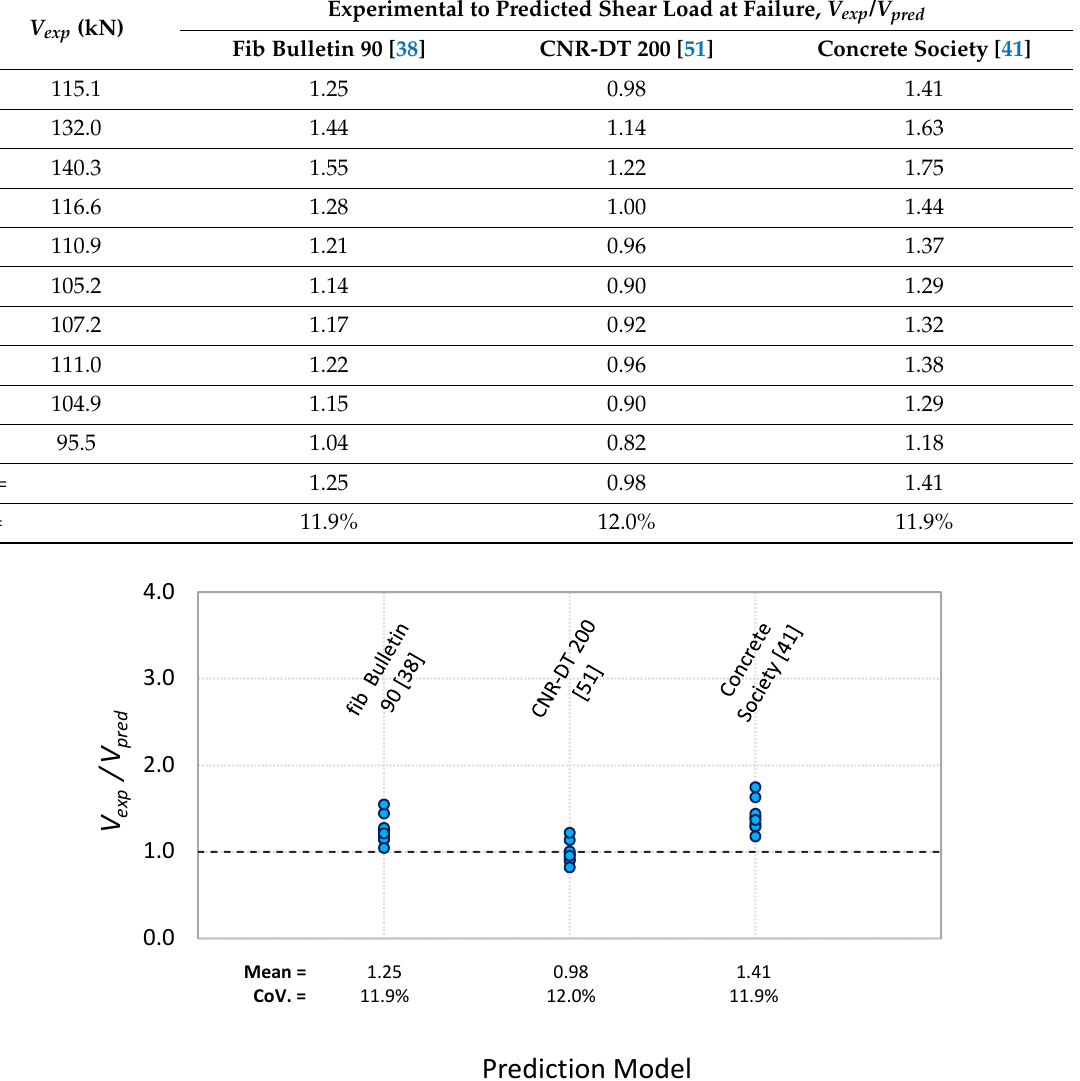
Figure 12. Comparison of experimental and predicted plate end debonding capacity using fracture energy-based models.